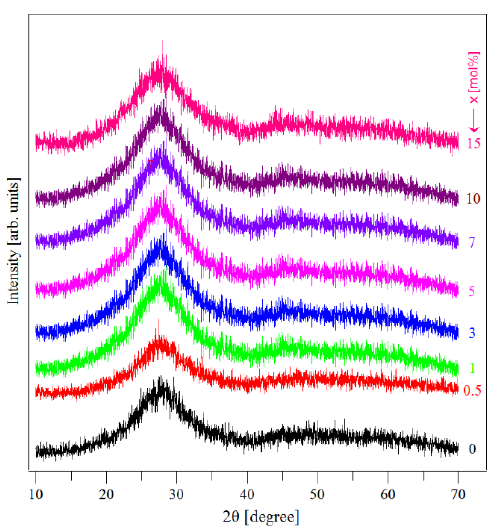
Figure 1 . XRD patterns of the (CuNPs) x ·(P 2 O 5 ) 35 ·(Sb 2 O 3 ) (64−x) ·(Sm 2 O 3 ) 1 glasses.